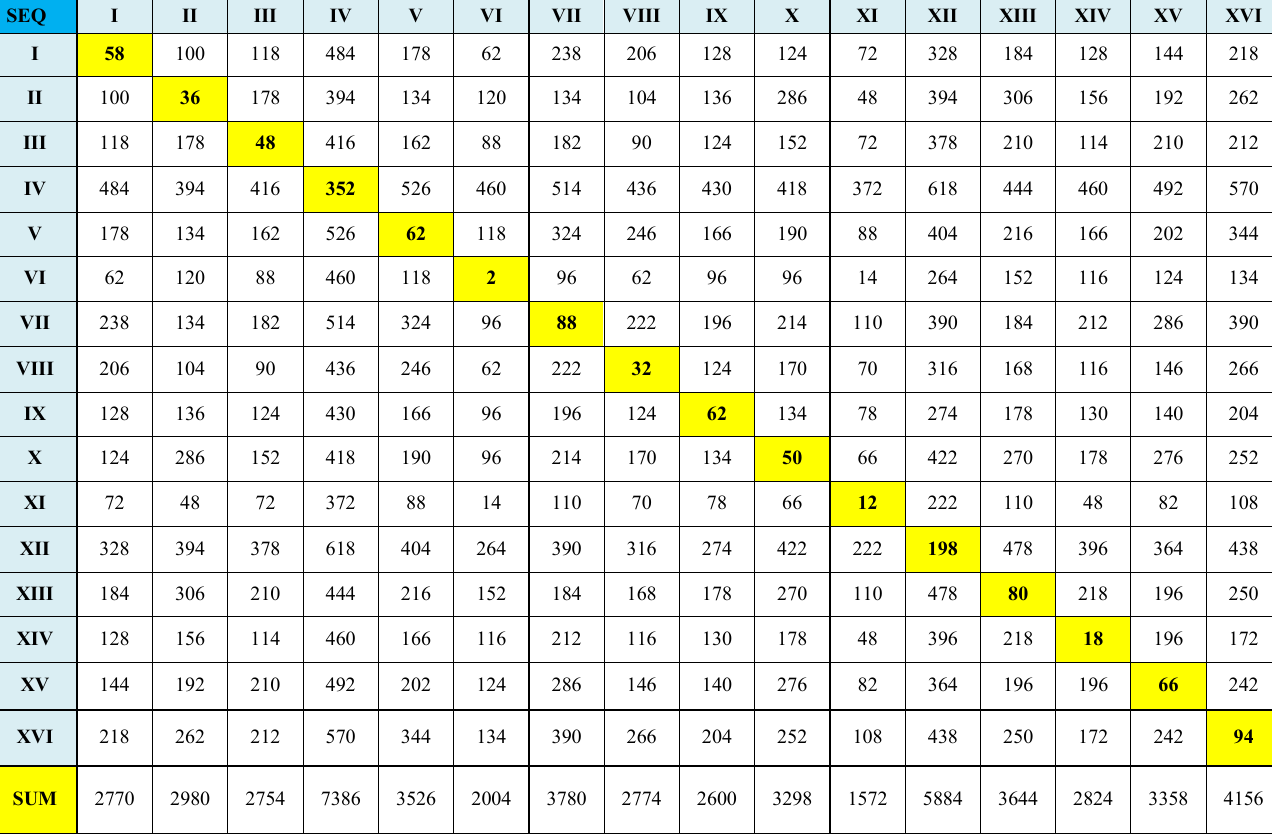
Table 6. Comparison of Intra Vs Inter Chromosomal Repeats of Saccharomyces Cerevisiae S288C, which clearly shows the Improvement in the Number of